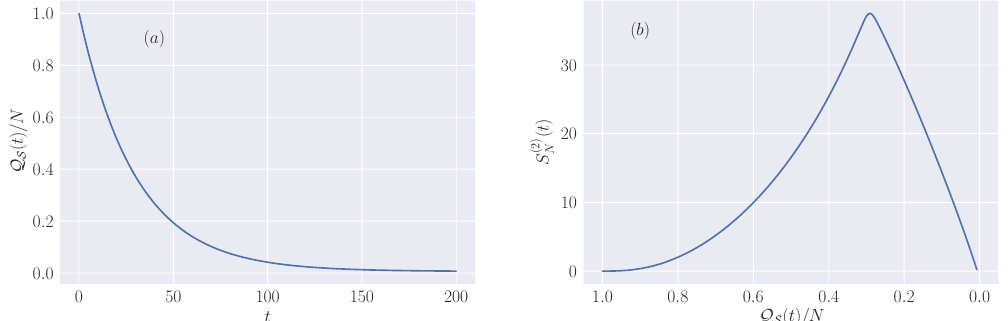
Figure 7 . Sub(cid:12)gure ( a ): time evolution of the system charge ( t ) de(cid:12)ned in eq. (3.37). Sub(cid:12)gure Q S ( b ): R(cid:19)enyi entropy S (2) ( t ) as a function of the charge ( t ) (note the inverted scale on the x -axis). N Q S The plots correspond to a random evolution in the presence of a global U(1) conserved charge, while the system is initialized as in eq. (3.18). The evolution parameters are set to (cid:21) 1 = 1 and (cid:21) 2 = 2, and the system size is N =